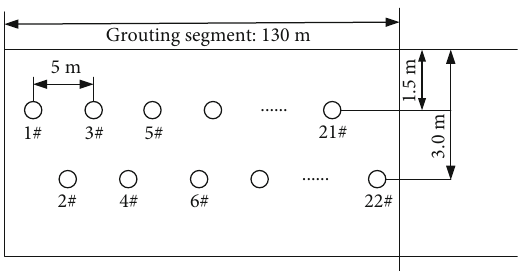
Figure 5: Split grouting device.